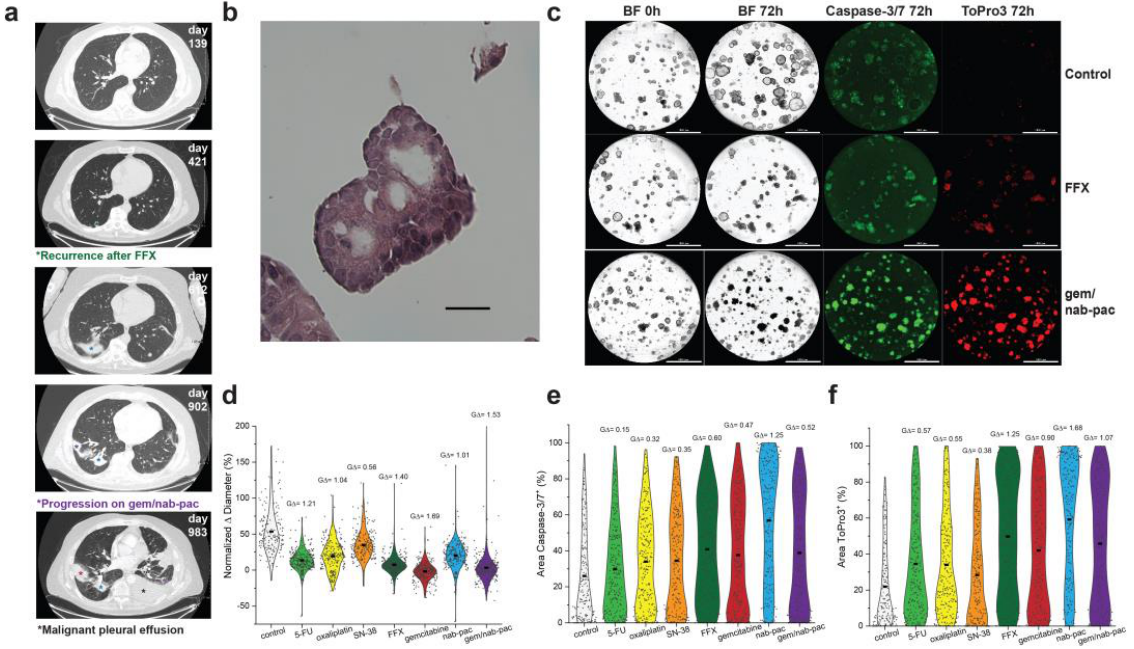
Figure 4. Therapeutic response assessment of clinical resistance. ( a ) Clinical course of PDAC2 including serial CT thorax showing recurrence after neoadjuvant FFX (green*, day 421), pulmonary disease progression (violet*, day 902), and the development of malignant pleural effusion (black*, day 983), with a corresponding site of prior irradiation (blue*). ( b ) H&E staining of PDAC2 organoids displaying typical cancer phenotypes, such as nuclear atypia and a high N/C ratio; scale bar is 20 μm. ( c ) Images of PDAC2 organoids by treatment type, including media control (top row), FFX (second row), and gem/nab-pac (third row), with brightfield microscopy at 0 h and 72 h, and fluorescence microscopy for caspase-3/7 (apoptosis) and ToPro3 (necrosis) at 72 h. The third row shows gem/nab-pac treatment; scalebar is 1000 µ m. ( d ) Violin plot of normalized % change in diameter of PDAC2 organoids treated with chemotherapies and their respective effect sizes. ( e ) Violin plot of % of area positive of caspase—3/7 for PDAC2, when treated with chemotherapies, and their corresponding effect sizes. ( f ) Violin plot of % of area positive of ToPro3 for PDAC2 when treated with chemotherapies and their respective effect sizes.